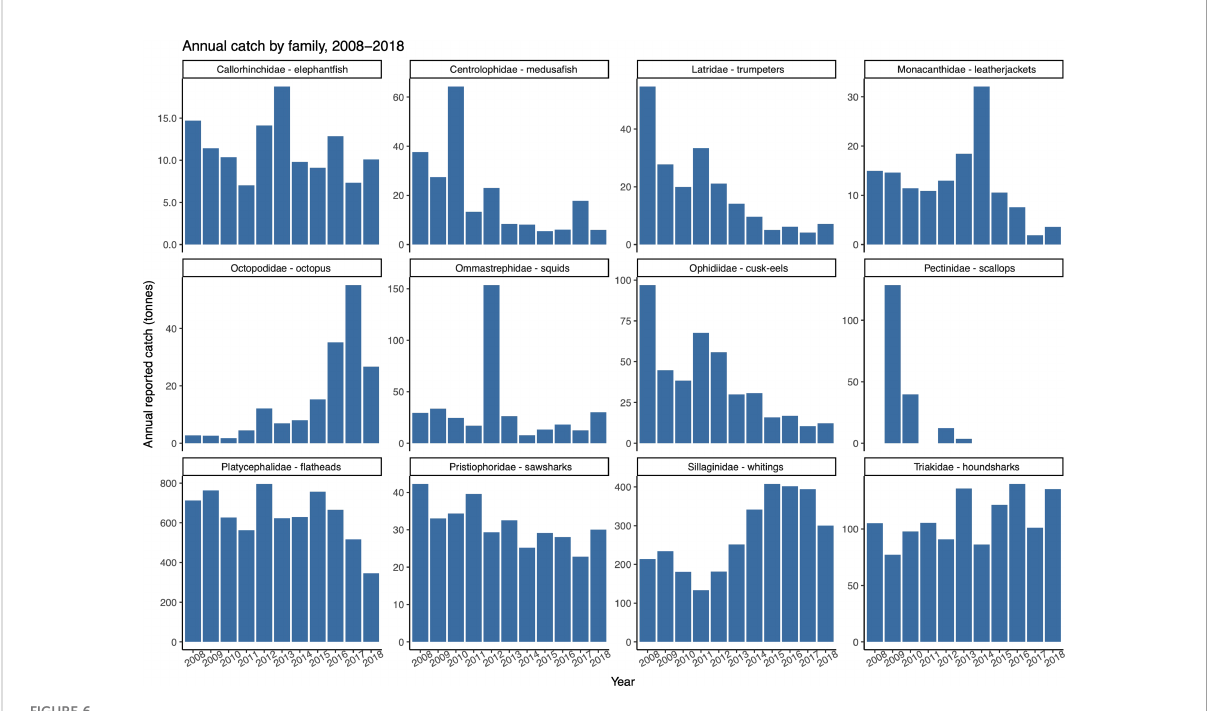
FIGURE 6 Annual catch of 12 families by fi sheries operating near oil and gas structures